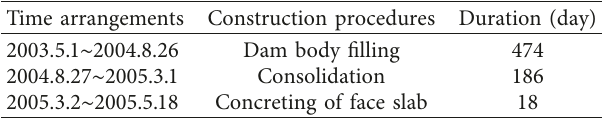
Figure 9: Three-dimensional finite element mesh. Table 1: Main construction schedule for the Langyashan